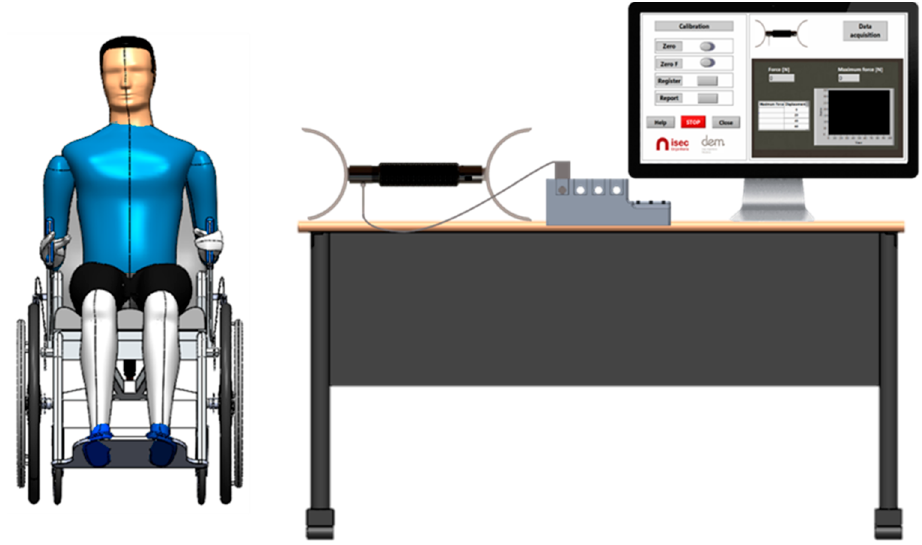
Figure 14. Setup of tests at Hospital Rovisco Pais.